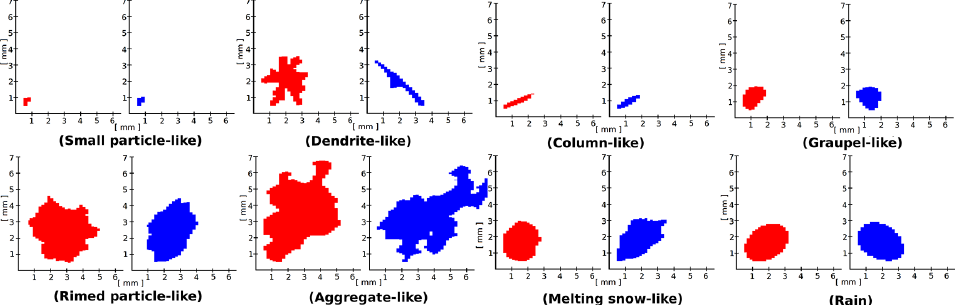
Figure 4. Examples of particle images (two camera views: A left, B right) belonging to time steps dominated by a particular hydrometeor